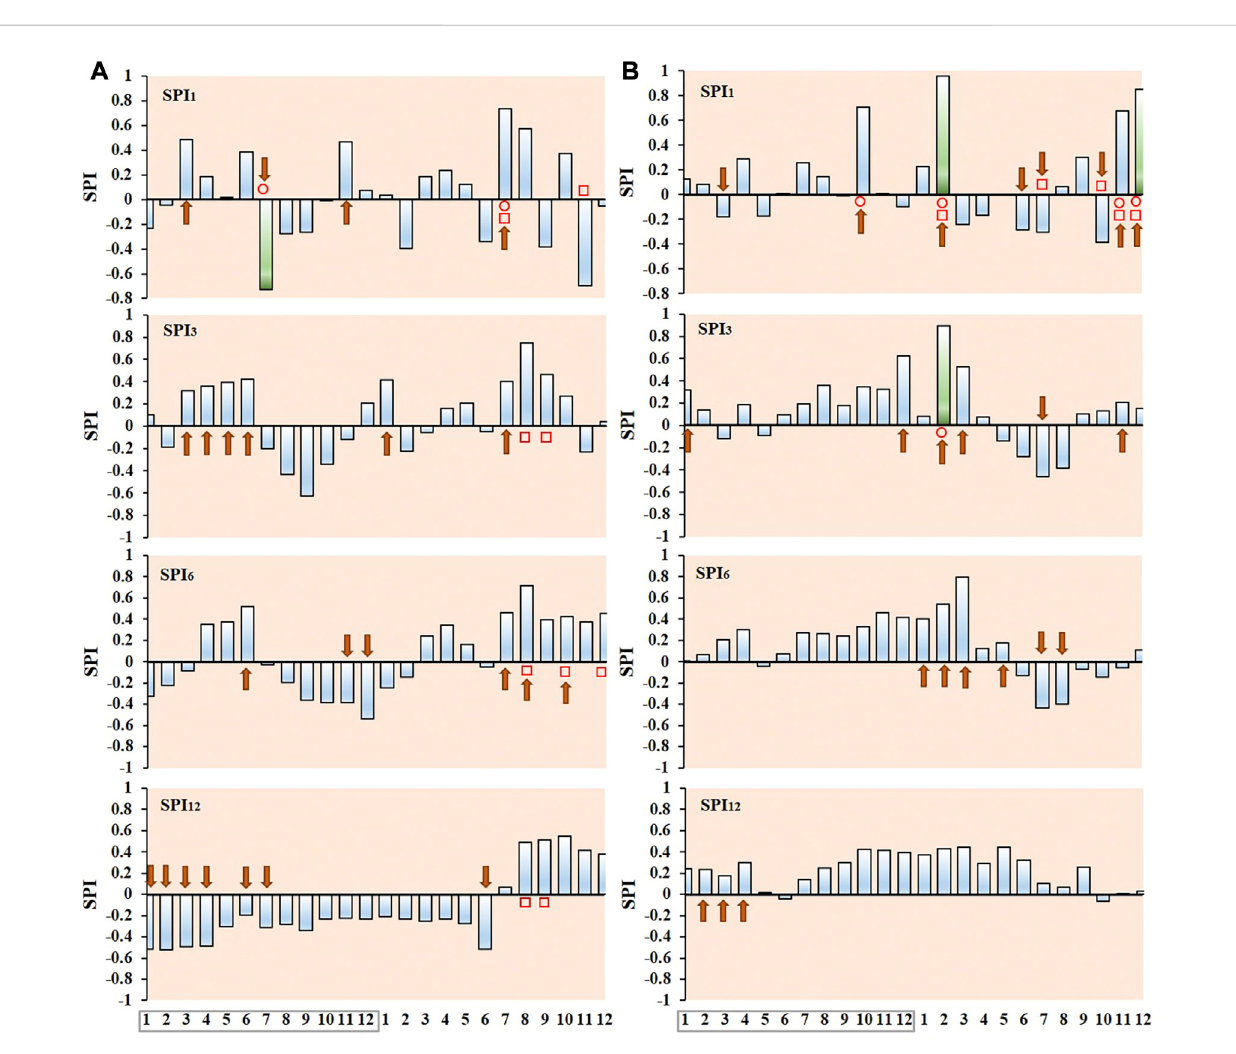
FIGURE 11 Mean SPI values at different timescales from SPI series in the southeast region. (A) El Niño and (B) La Niña years (boxed) and the year after these events. Same as Figure